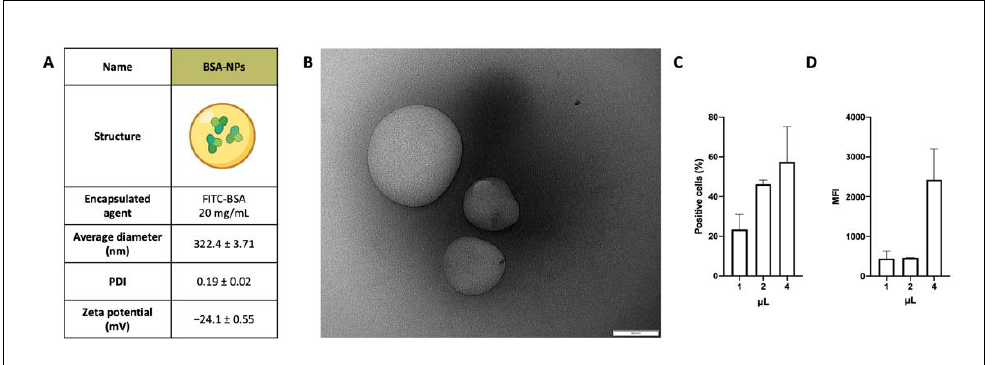
Figure 1. NPs ’ characterization : ( A ) Physicochemical characteristics of BSA-NPs, which are com- posed of PLGA-PVA polymers and filled with FITC-conjugated BSA. ( B ) TEM image of NPs (scale bar 100 nm). Nalm-6 cells were incubated with different amounts of NPs and analyzed by flow cytometry to evaluate their binding/internalization. ( C ) The percentage of positive cells and ( D ) Mean Fluorescence Intensity (MFI) are reported in the histograms. Data are reported as the mean ±